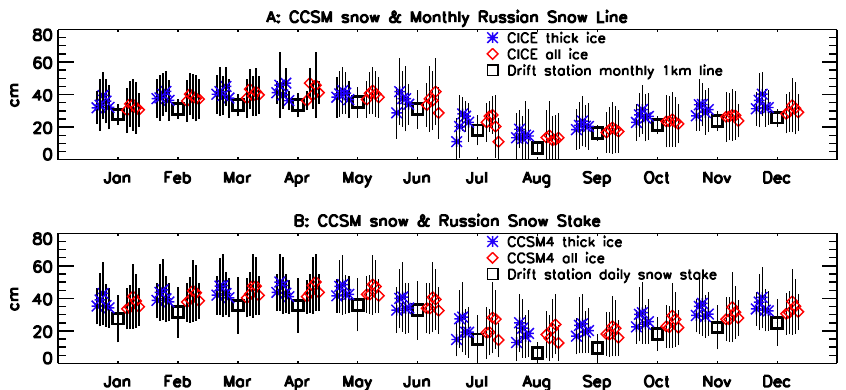
Fig. 1. Panels (a) and (b) : CCSM Arctic Ocean snow depths for the period 1954–1993 validated against Russian drift station measurements. Panel (a) displays the Russian snow line as the in situ data; panel (b) uses the Russian snow stake as the in situ data. Each ensemble member is reported separately. Black squares indicate the in situ values for the period; red diamonds indicate the snow depth overlying the nearest ice of any thickness; blue asterisks indicate the snow depth overlying the nearest ice with greater than 1.49m thickness. Vertical bars indicate one standard deviation for both in situ and model snow depths.